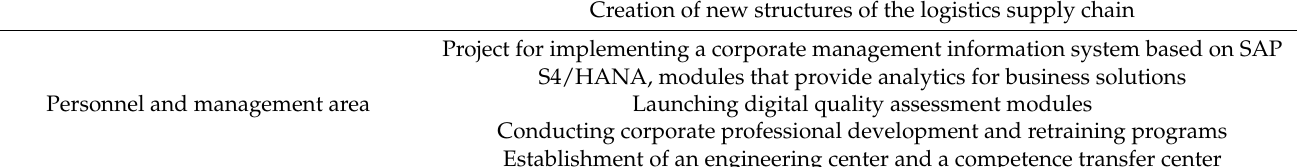
Production and technical